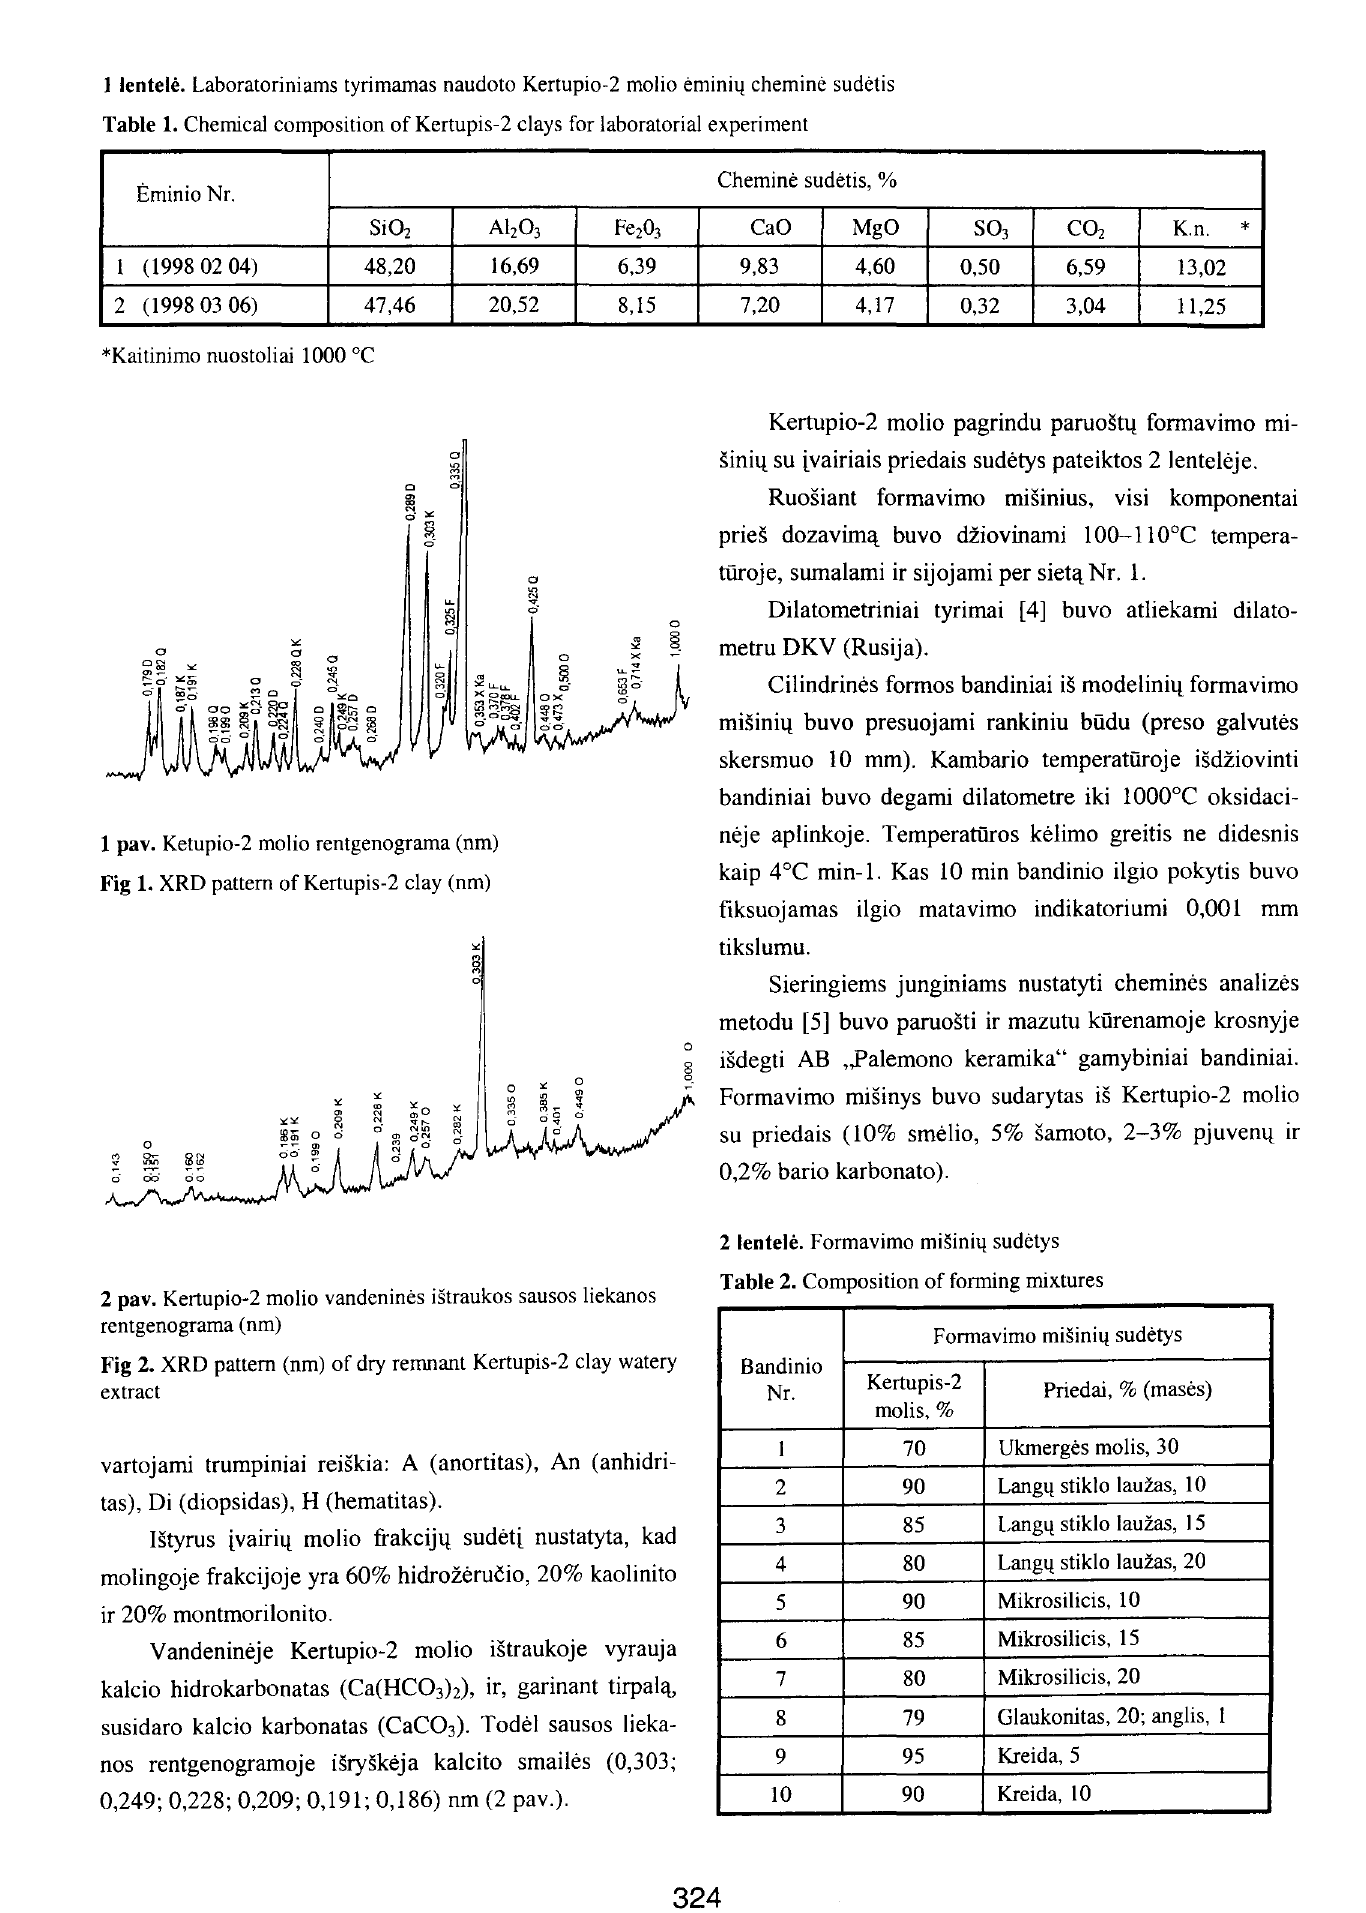
Fig 2. XRD pattern (nm) of dry remnant Kertupis-2 clay watery extract